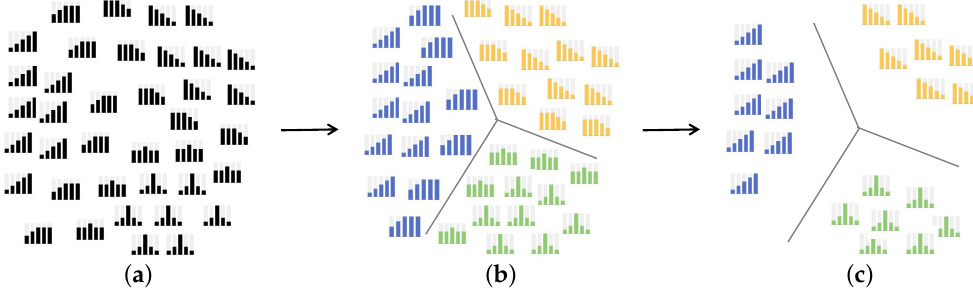
Figure 8. Workflow for labeling visualizations to generate the training set. The workflow integrates three steps, i.e., ( a ) sample collection, ( b ) clustering, and ( c ) pattern purification.